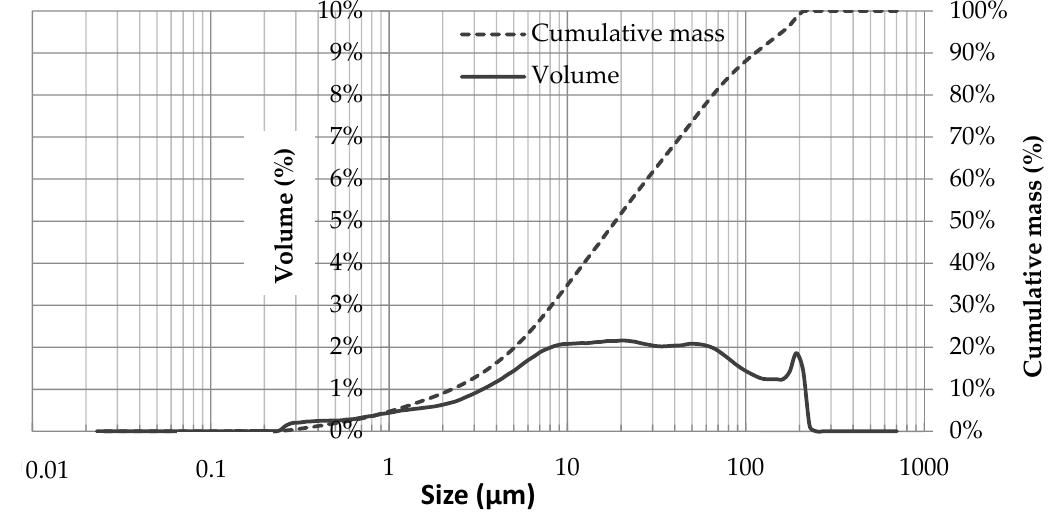
Figure 2. Low magnification ( a ) and high magnification ( b ) scanning electron microscopy of wood ash (WA).